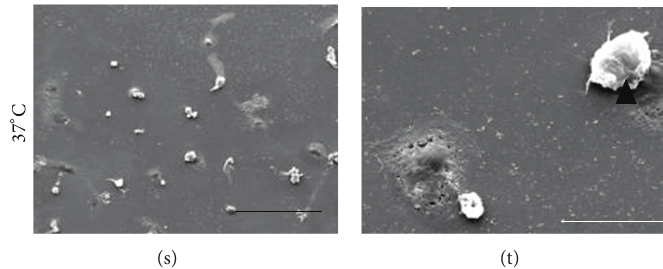
Figure 5: Photomicrographs of control cells and cells stored for seven days at 4 ∘ C, 8 ∘ C, 12 ∘ C, 16 ∘ C, 20 ∘ C, 24 ∘ C, 28 ∘ C, 32 ∘ C, and 37 ∘ C were captured by a scanning electron microscope. An epithelial cobblestone morphology can be seen in the control ((a), (b)), and this was best maintained after storage at 12 ∘ C, 16 ∘ C, and 20 ∘ C ((g)–(l)). The cells demonstrate apoptotic morphological alterations like shrinkage and membrane blebbing after storage at temperatures below 12 ∘ C ((c)–(f)) and above 20 ∘ C ((m)–(t)). Images are representative of three independent samples. Scale bars: 100 𝜇 m (black), 20 𝜇 m (white). Black arrowheads: shrinkage and membrane blebbing. White arrowheads: microcracks representing artifacts due to sample preparation.